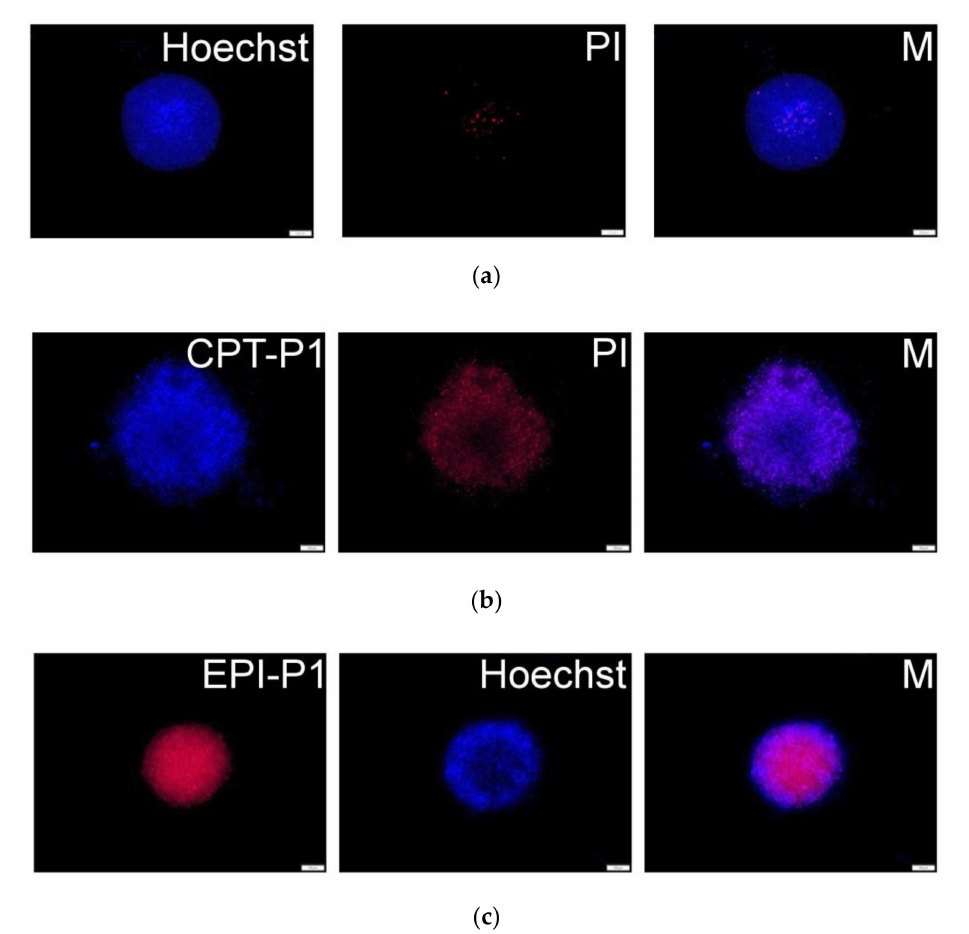
Figure 8. ( a ) MCF-7 spheroid fluorescence images without particles and propidium iodide or Hoechst staining. ( b ) Spheroids with 0.1 mg/mL of CPT-P1 aggregates, propidium iodide (PI) and merged pictures (M). ( c ) Spheroids with 0.1 mg/mL of EPI-P1 aggregates, Hoechst 33,342 and merged pictures (M). Scale bars represent 100 µ m (see structures in Figure